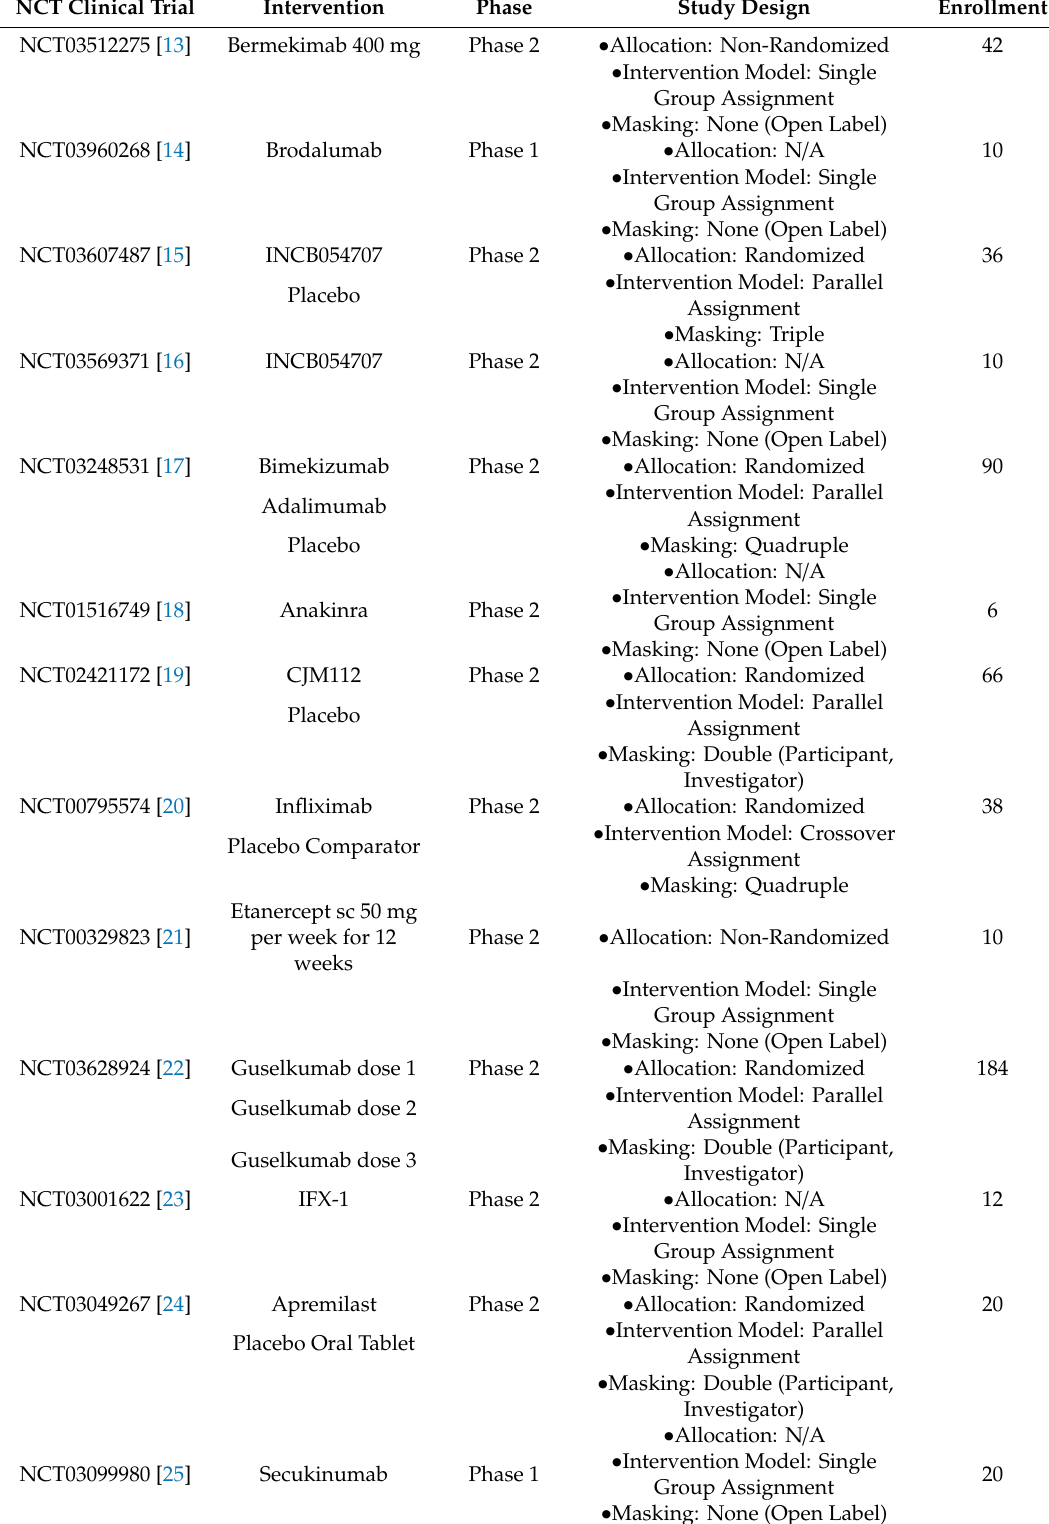
Table 1. Completed interventional studies on target